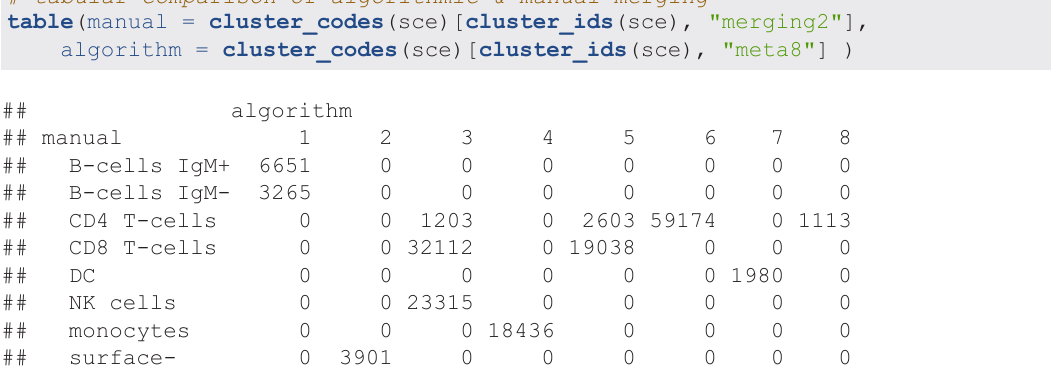
table (manual = cluster_codes (sce)[ cluster_ids (sce),